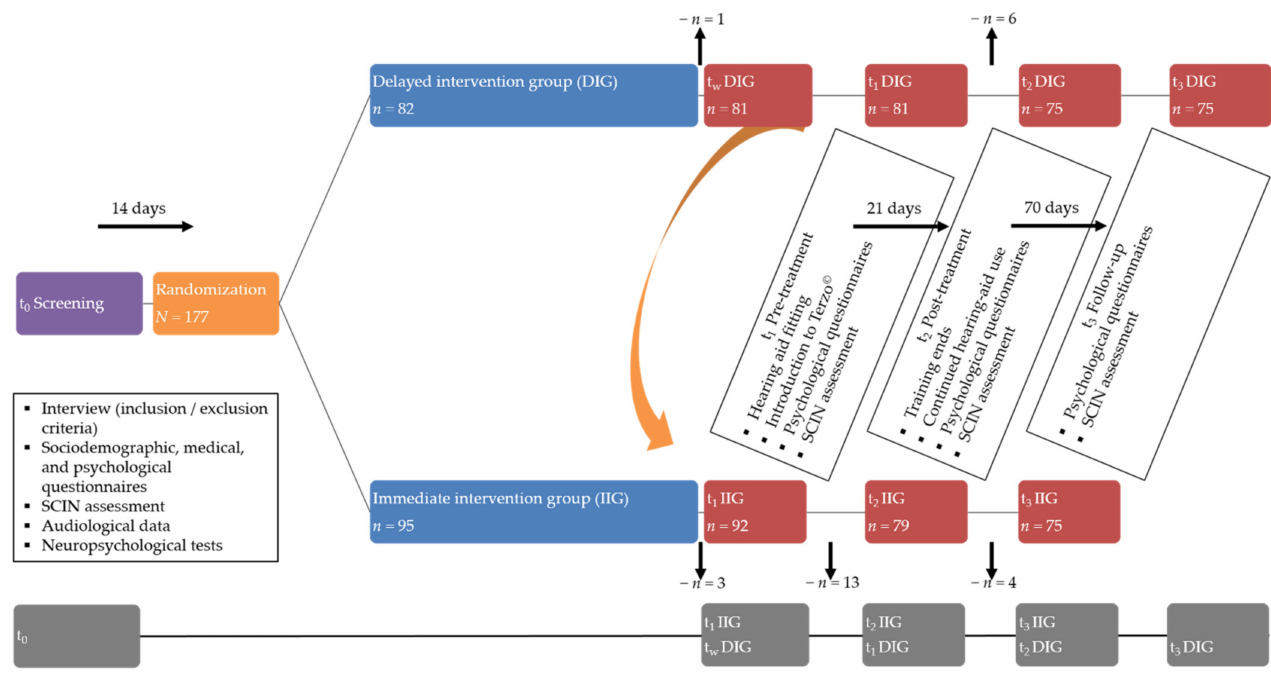
Figure 1. Overview of the randomized-controlled cross-over design, measurement timepoints, and dropouts. IIG = immediate intervention group and DIG = delayed intervention group. SCIN = Speech-comprehension-in-noise; t 1 = Pre-treatment; t 2 = Post-treatment; t 3 = Follow-up; and t w = Waiting timepoint (DIG only). Dropout rates are indicated for each arm and measure- ment